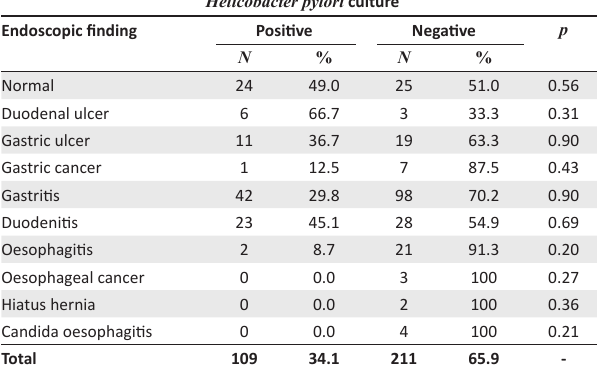
TABLE 2: Endoscopic finding with distribution of Helicobacter pylori at